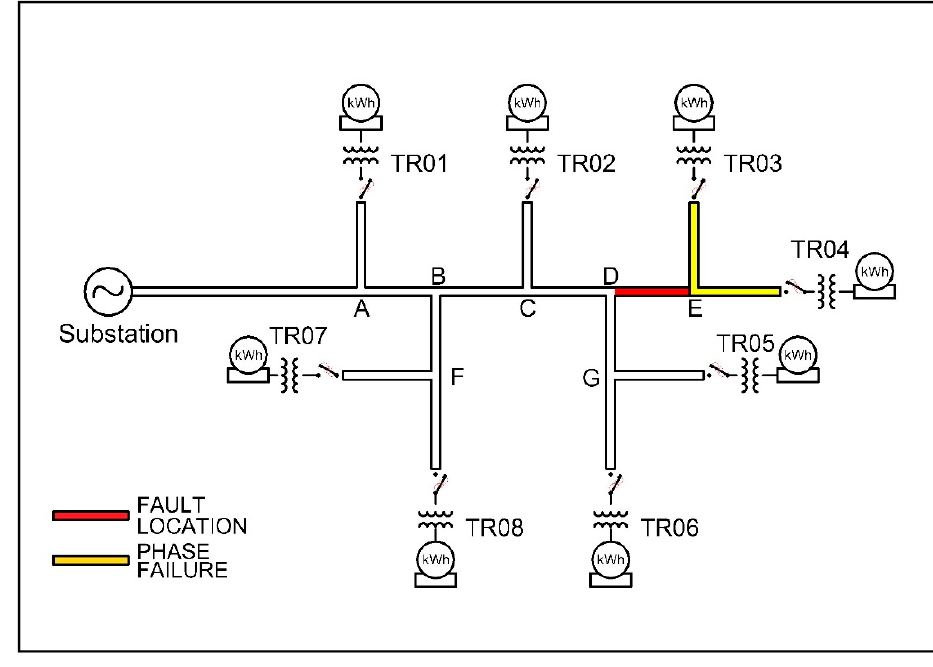
Figure 7. Faults on section DE.